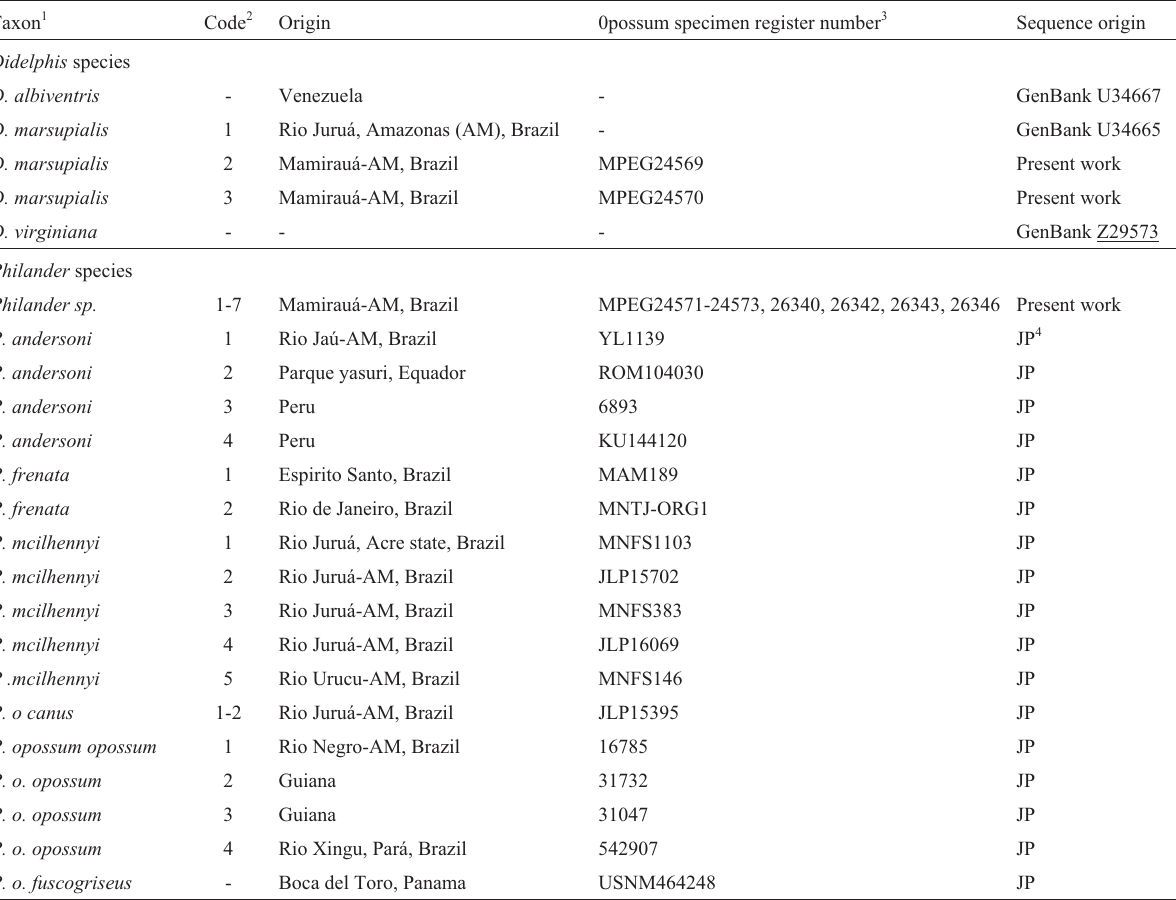
Table 1 - Specimens and cytochrome B (CytB) sequences used in our study. Taxon